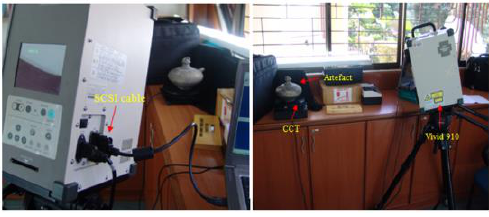
Figure 4. Scanning of artefact using VIVID 910 scanner